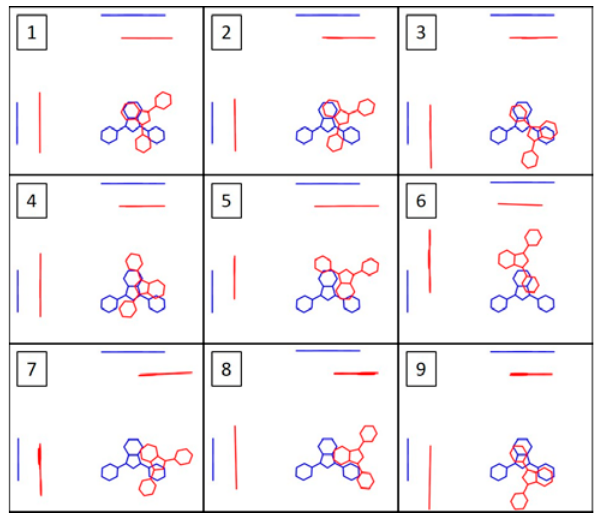
Figure 4. Multi-view projections of the nine best pairs of the C 2 rotamer of 1,3-diphenylisobenzofuran optimized for the rate of sin- glet fission. The computed rate constants for biexciton formation relative to the rate computed for the structure actually found in the crystal, in the order 1-9, are 4306, 2944, 2261, 896, 892, 806, 717, 546, and